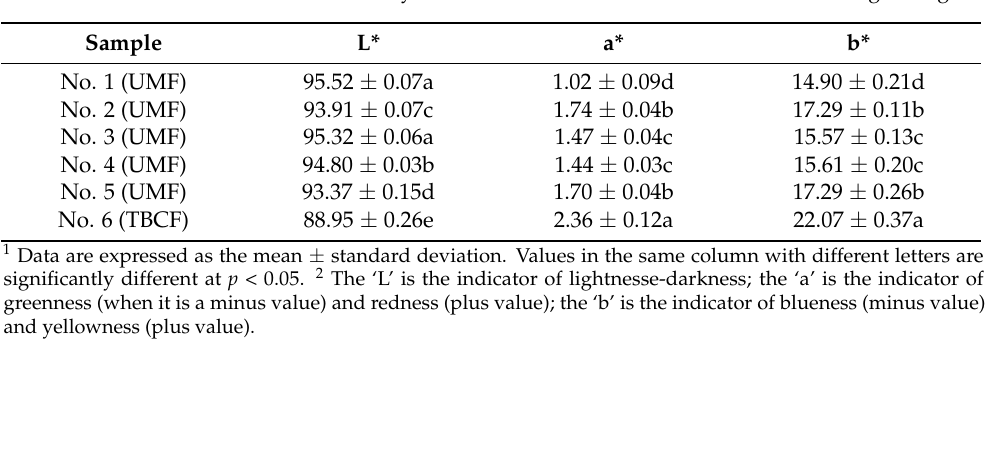
Table 2. Color difference of different Tartary buckwheat flour obtained from airflow ultrafine-grinding 1,2